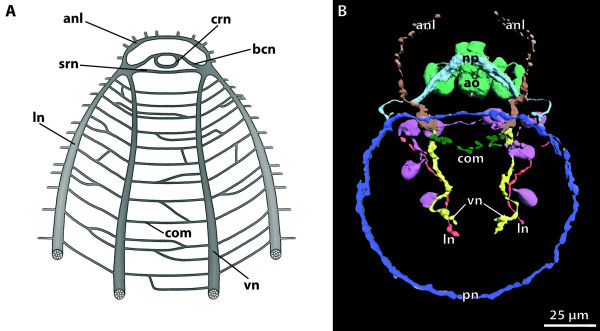
Tetraneurion. A. Semischematic representation of the nervous system of basal mollusks. Ventral view. Note the different planes in which the ventral and the dorsal nerve chords are situated. B. 3D-reconstruction of the nervous system of the creeping-type larva of the entoproct Loxosomella murmanica. Somata are depicted in magenta. [3D-reconstruction based on serotonin-like immunoreactivity.] Abbreviations: anl = anterior neural loop; ao = apical organ; bcn = buccal nerve; com = commissure; crn = circumoral nerve; ln = lateral neurite bundle; np = neuropil; pn = prototroch neurite; srn = subradular nerve; vn = ventral neurite bundle. A: After [336]; B: Modified from [37].